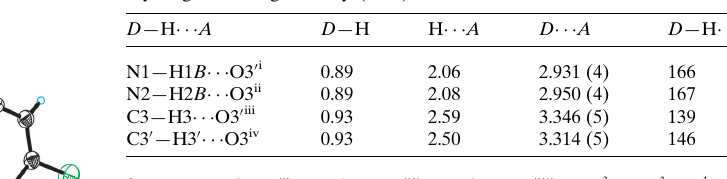
Table 1 Hydrogen-bond geometry (A˚ , (cid:4) ).